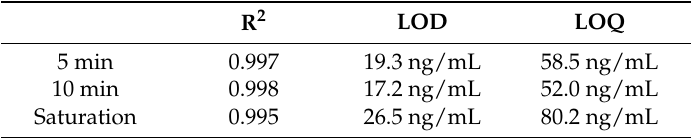
Figure 8. Dose-response curves for OTA at different measurement time points. Table 2. R 2 , LOD and LOQ values of the developed OTA sensor at different time